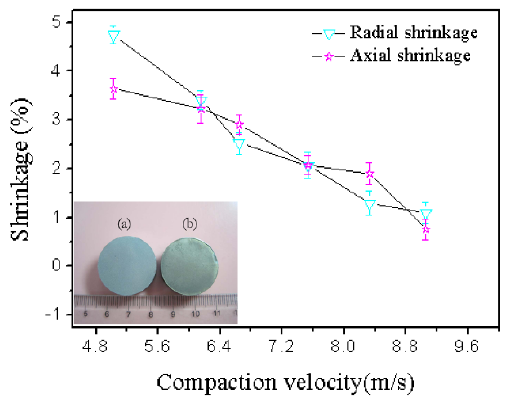
Figure 7. Shrinkage versus compaction velocity and cylindrical. Shapes of the green ( a ) and sintered ( b ) samples.